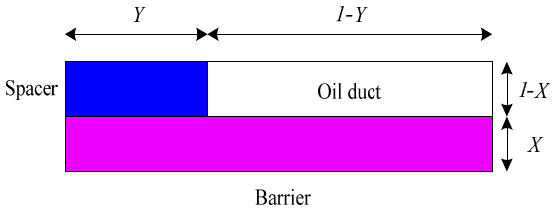
Figure 8. XY model of transformer main insulation system.